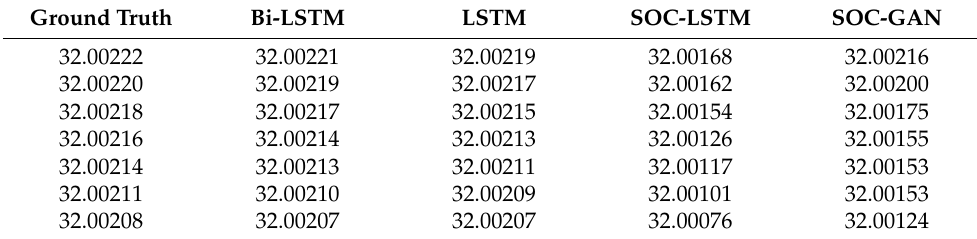
Table 4. Ship trajectory segment prediction performance on latitude data samples.